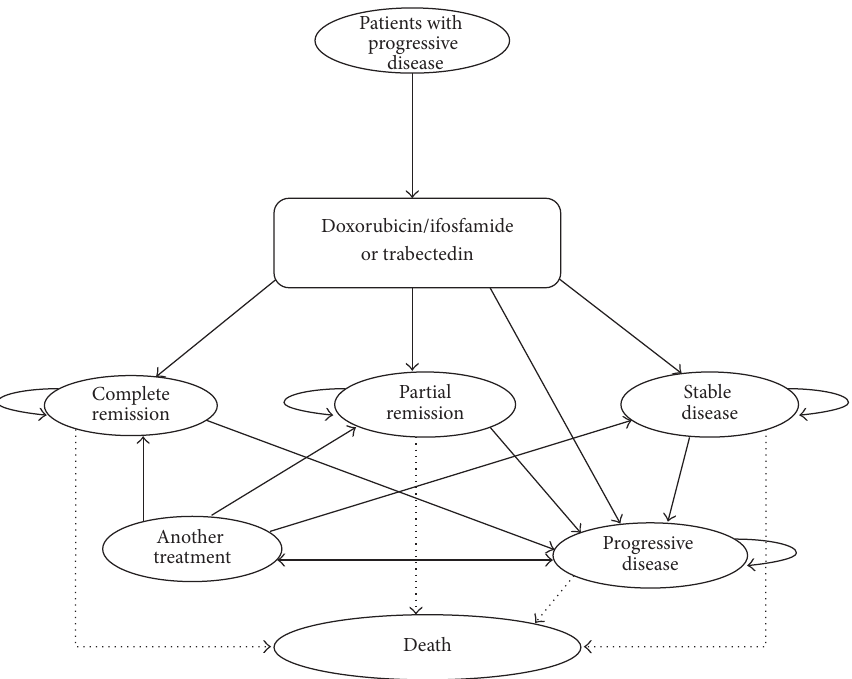
Figure 1: Markov model depicting the management of ASTS in Italy, Spain, and